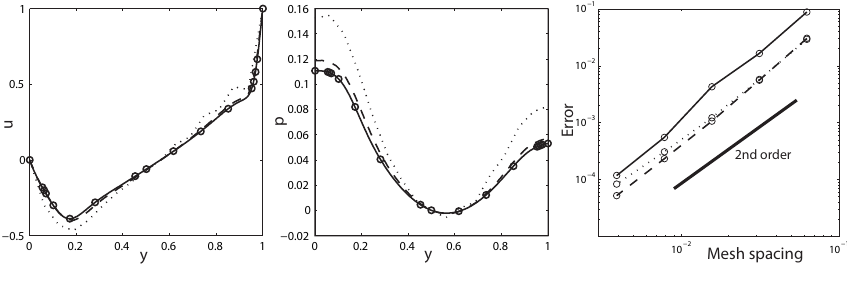
Fig. 4. Left and centre: Numerical approximations to u and p at three resolutions: 1x = 1 / 16 (dotted line), 1 / 32 (dashed line) and 1 / 256 (solid line). The values from Botella and Peyret (1998) are plotted as circles. Right: The root-mean-square errors between the numerical solution and the data from Botella and Peyret (1998) for u (solid line) and p (dashed line), and the absolute value of the difference between the numerical and benchmark kinetic energy (dotted line) taken from Bruneau and Saad (2006). A line indicating second order convergence is also